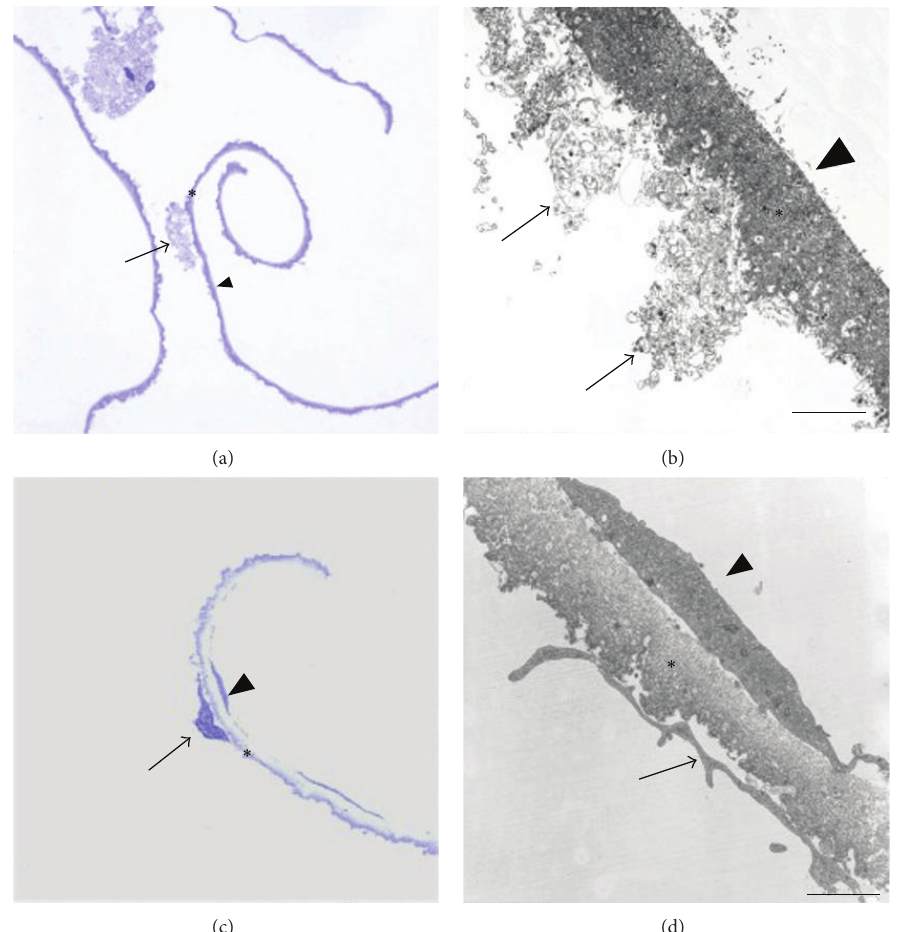
Figure 3: Light micrographs (LM) and transmission electron micrographs (TEM) of the ILM (asterisks) removed from eyes with diabetic macular edema ((a) and (b)) and stage IV idiopathic macular hole ((c) and (d)). The ILM is characterized by an undulated retinal side and a smooth vitreal side. ((a), (b)) Cell membrane fragments (arrow) on the retinal side of the ILM. The vitreal side of the ILM (arrowhead) is devoid of cells and collagen. ((c), (d)) LM shows a cell (arrow) with nucleus on the retinal side of the ILM. EM shows one large cell fragment (arrow) in contact with ILM and a single cell on the vitreal side of the ILM (arrowhead), which is likely a fibrous astrocyte